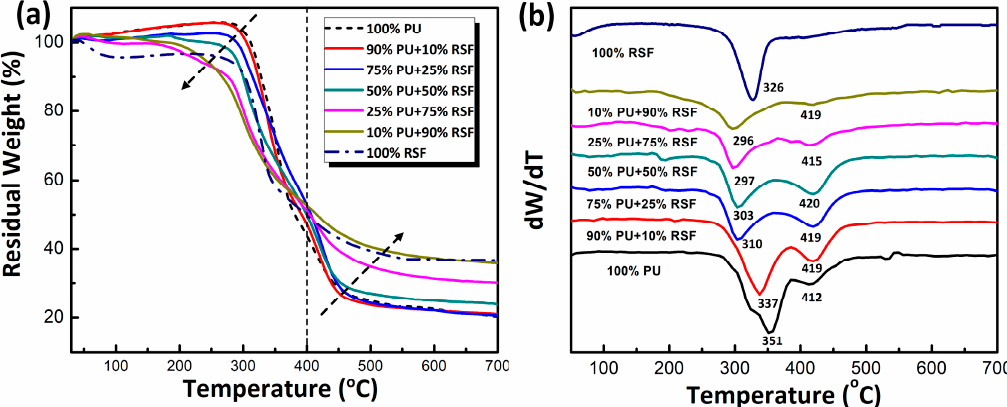
Figure 3. ( a ) Thermogravimetric Analysis (TGA) of PU/RSF blended fibres with different blend ratios; and ( b ) differential thermogravimetric (DTG) curves of PU/RSF blended fibres with different blend ratios.